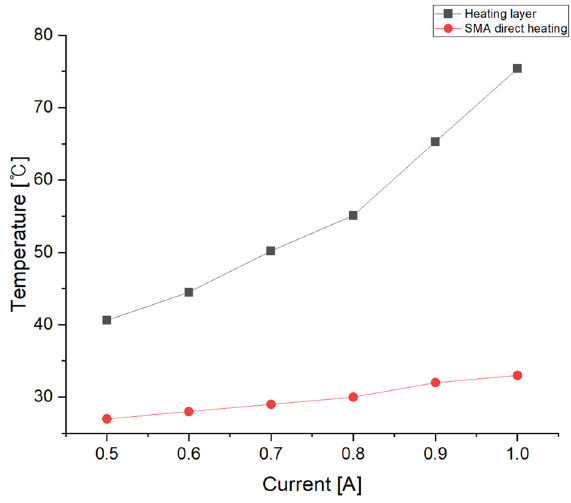
Fig. 8 Temperature dependence on the current in heating layer and SMA